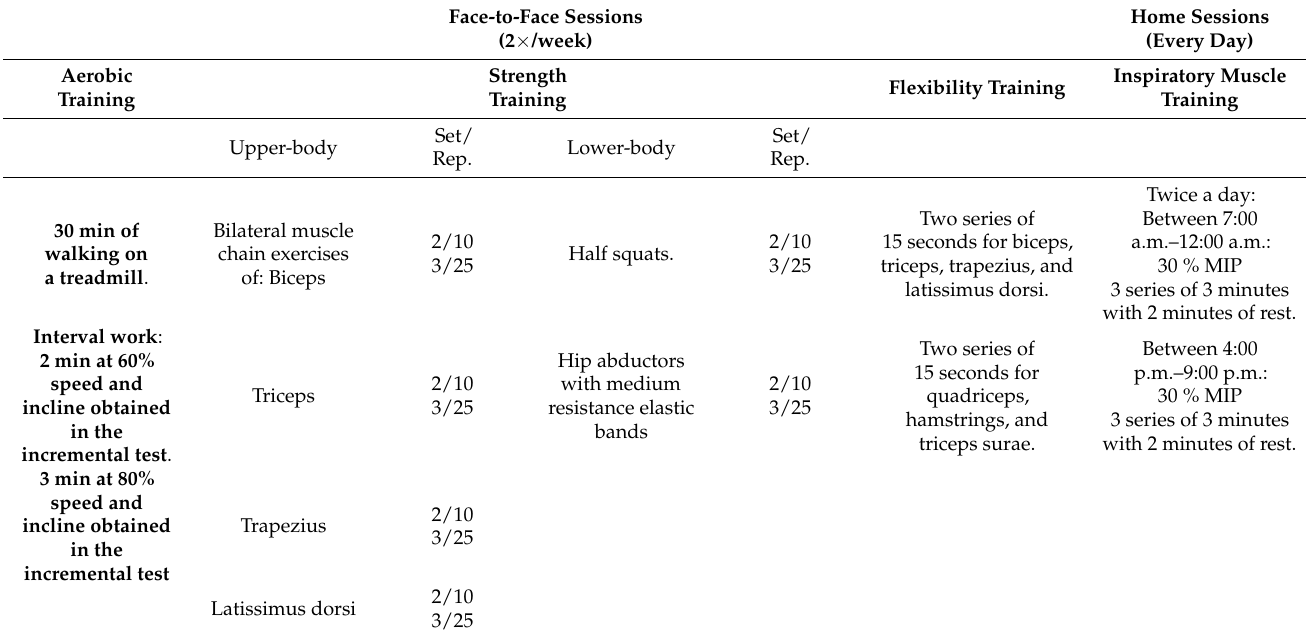
Table 1. Description of the pulmonary rehabilitation